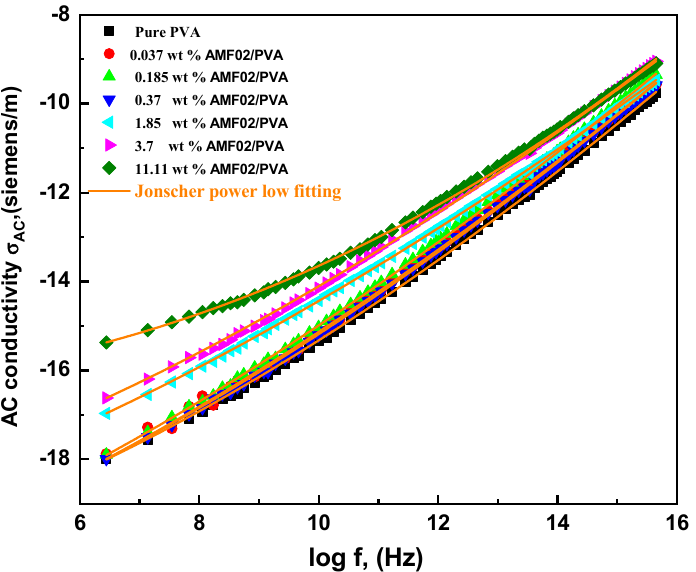
Figure 12. AC conductivity vs. frequency for different novel PCCEFs and the variation of Jonscher parameters with the wt. % AMF02 salt fillers.